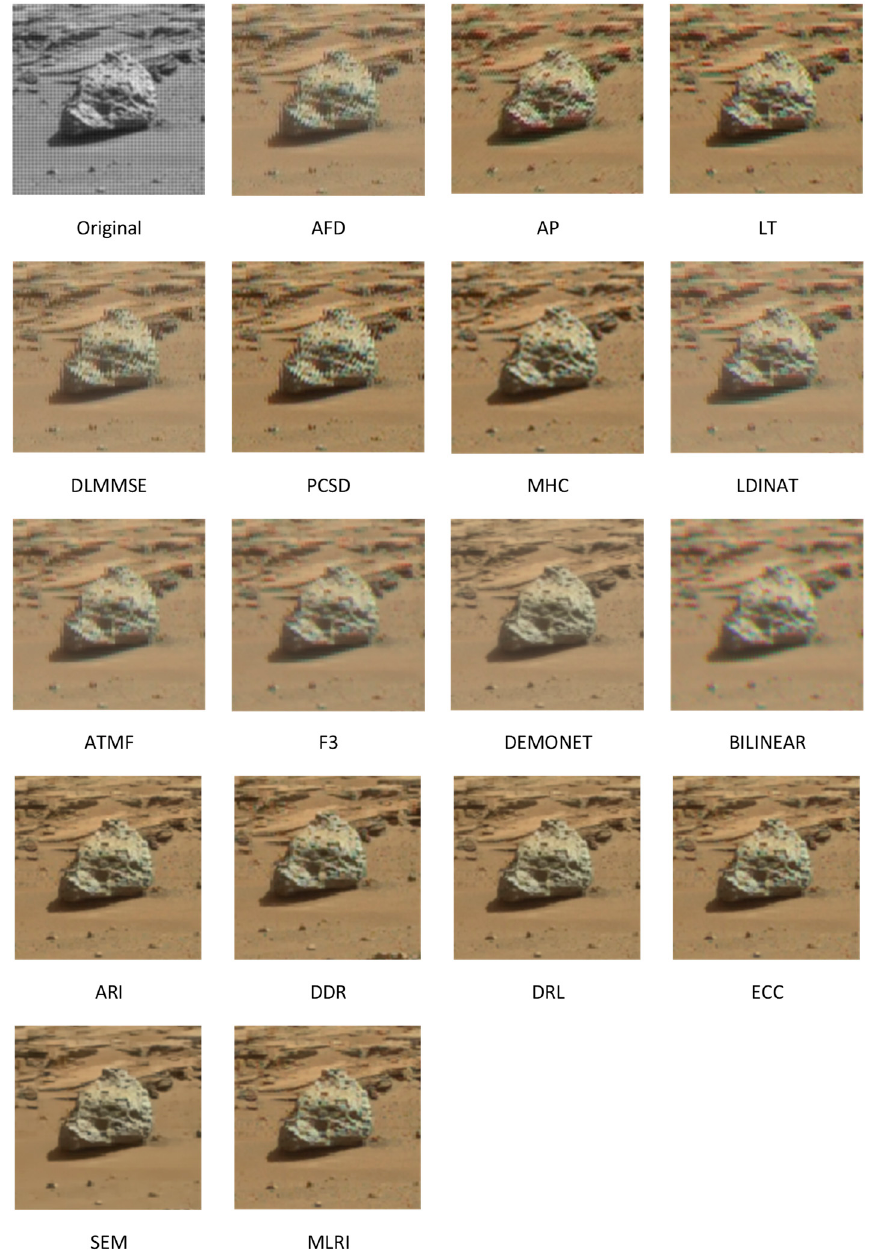
Figure 8. Subjective comparison of demosaiced images of different algorithms for left Mastcam image 6.